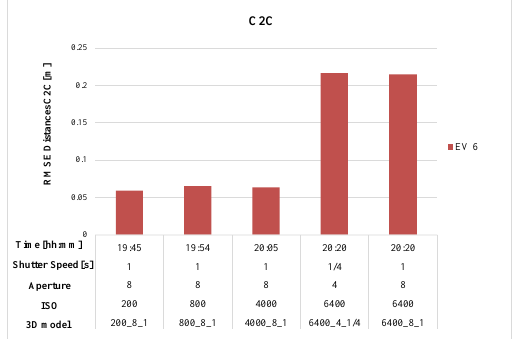
Figure 5 – RMSE of the absolute distances for the photogrammetric models computed with the C2C method during the evening astronomical twilight.